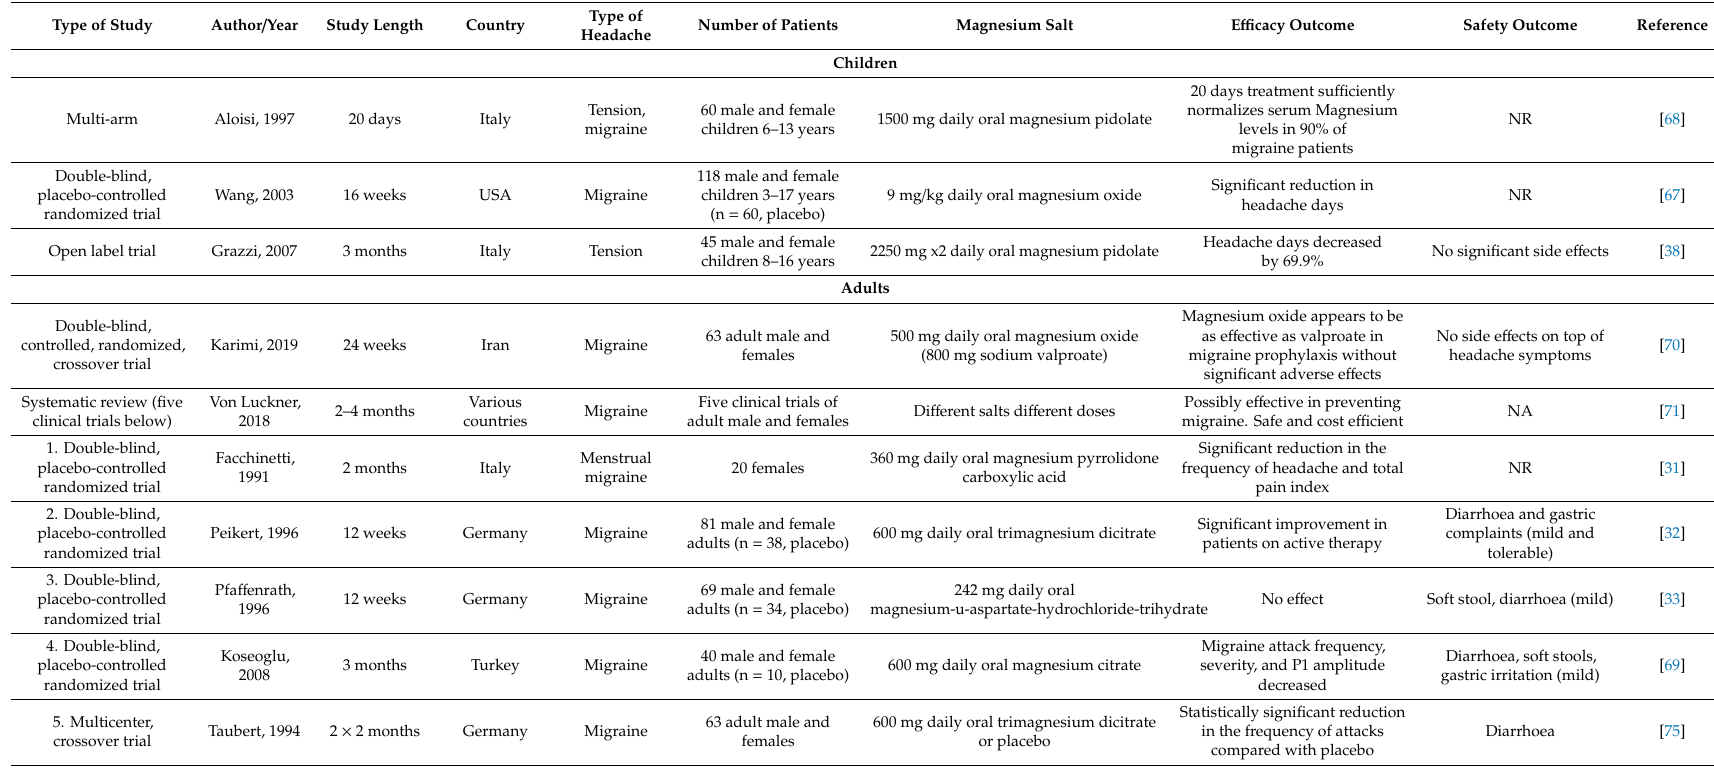
Table 3. E ffi cacy and safety of magnesium in treating headache